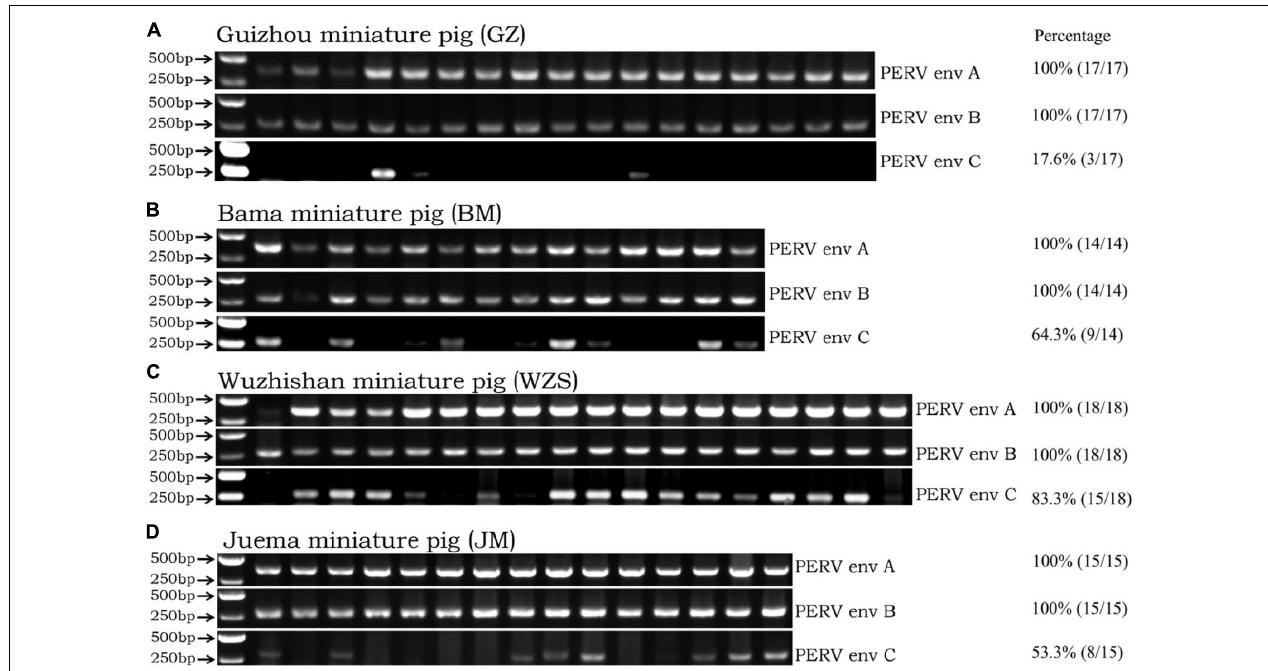
FIGURE 1 | The classical PCR method detects env-A, env-B, and env-C genes in the four miniature pig breeds. Panel (A) was the detection result for the GZ breed. Panel (B) was the detection result for the BM breed. Panel (C) was the detection result for the WZS breed. Panel (D) was the detection result for the JM breed. The quantification data of the prevalence of PERV env A, B, C in each pig breeds was listed on the right.